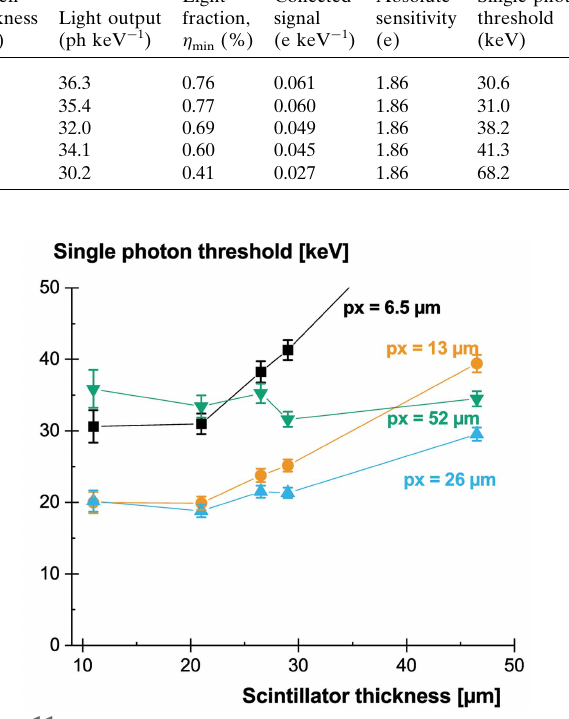
Figure 11 Single X-ray detection thresholds for GOS:Tb scintillating screens as a function of screen thickness and camera pixel size